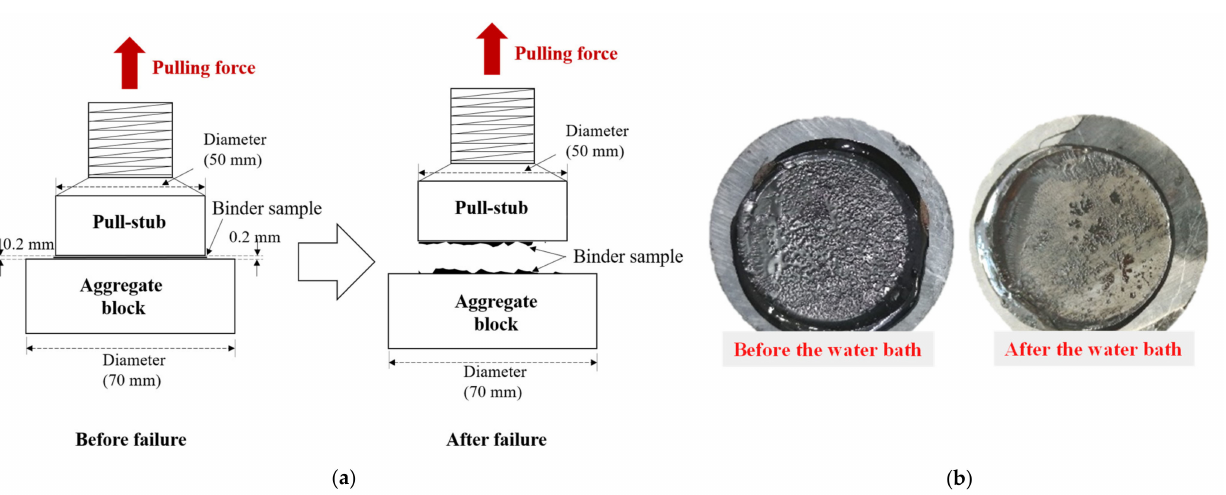
Figure 5. Setups for the pull-off test. ( a ) Schematic diagram of pull-off test; ( b ) Failure interface before and after wetting